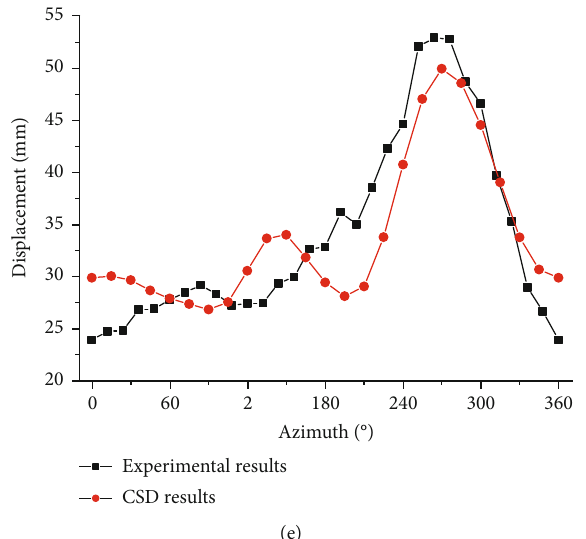
Figure 22: Comparison of the blade tip displacements between experimental and CSD results: (a) α = − 4 ° ; (b) α = − 2 ° ; (c) α = 0 ° ; (d) α = 2 ° ; (e) α = 4 ° . Table 2: Measurement accuracy in hover fl ight. θ ( ° ) Accuracy of hub targets